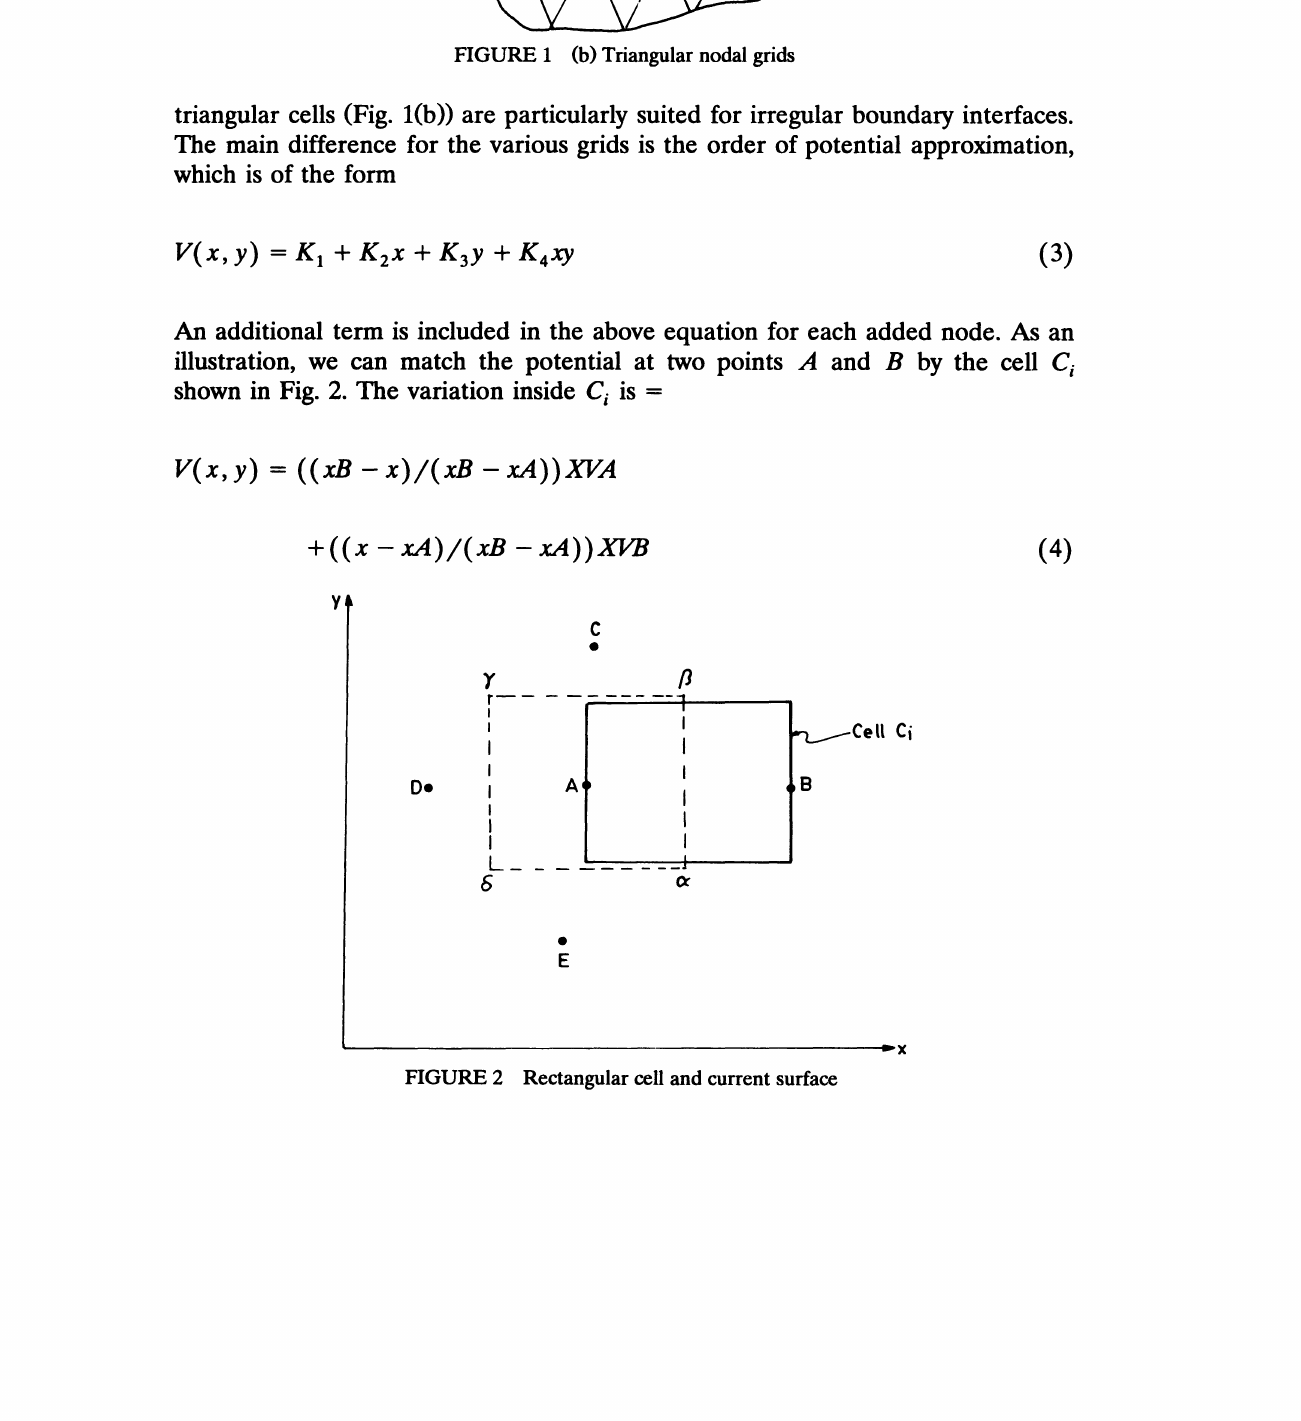
FIGURE 1 (b) Triangular nodal grids